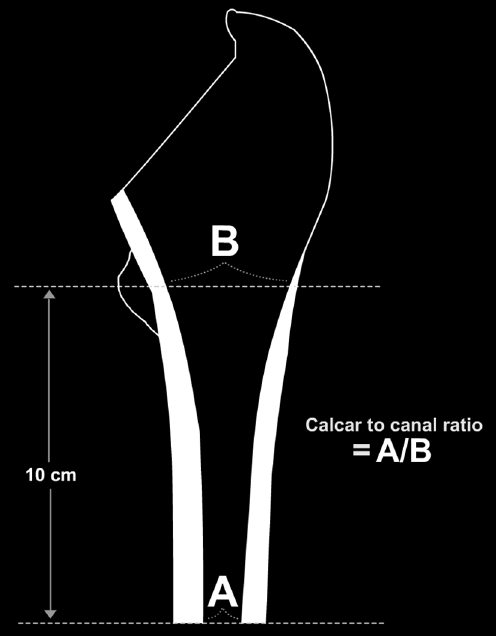
Figure 1. Calcar to canal ratio (CCR) is calculated by dividing the femoral canal diameter at a point 10 cm distal to the mid portion of the lesser trochanter ( A ) by the femoral canal diameter at the mid portion of the lesser trochanter ( B